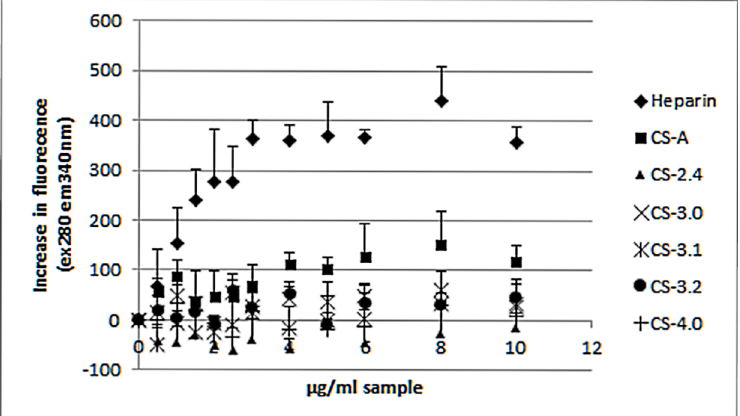
Fig 3. Antithrombin titration response for synthetic OSCS, native chondroitin sulfate and a heparin sample. The increase in fluorescence (ex280nm em340nm) response measured from antithrombin with increasing concentrations of each sample. Error bar is SD, n =